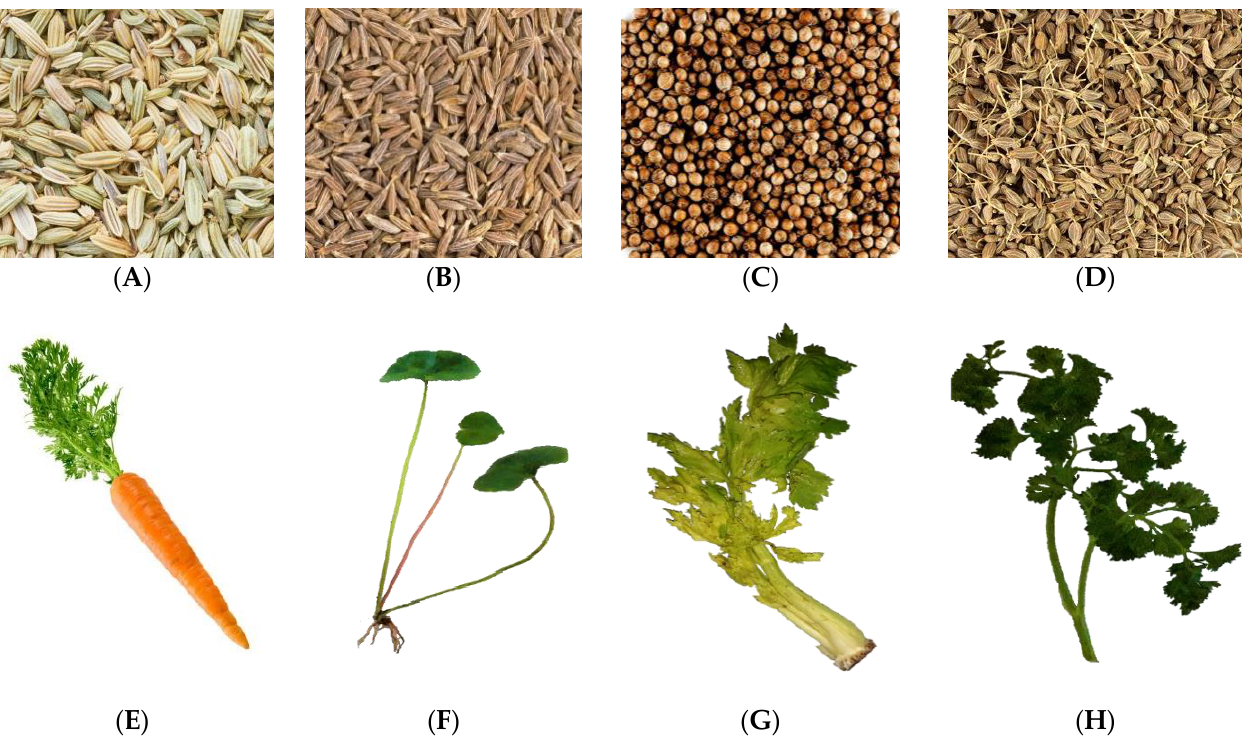
Figure 1. Different parts of selected Apiaceae family: ( A ) Fennel seeds; ( B ) Cumin seeds; ( C ) Coriander seeds; ( D ) Anise seeds; ( E ) Carrot; ( F ) Indian pennywort; ( G ) Celery plant; ( H ) Parsley (Photo courtesy of Thevin Randika).